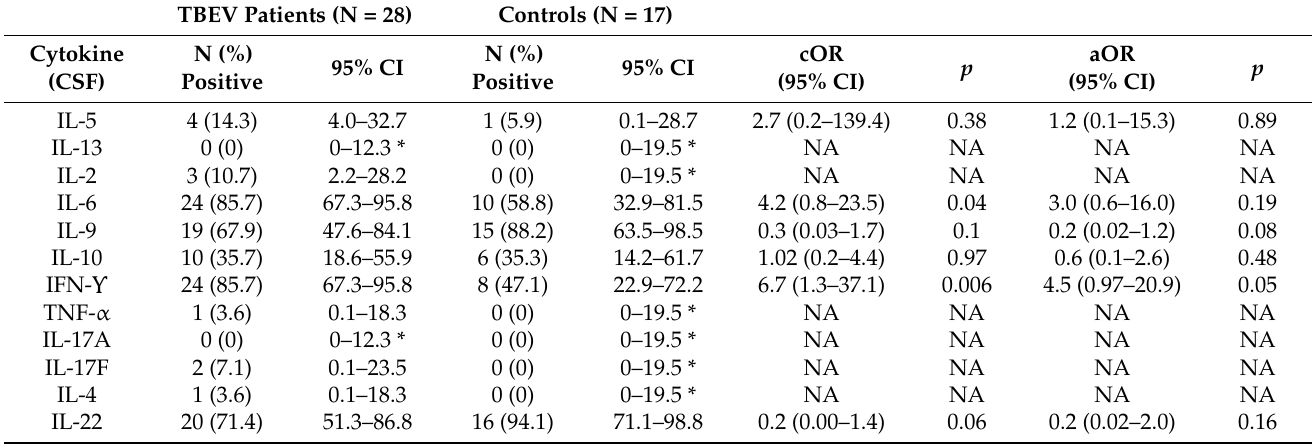
Table 3. Proportion of cytokine detection in CSF of TBEV patients and controls.